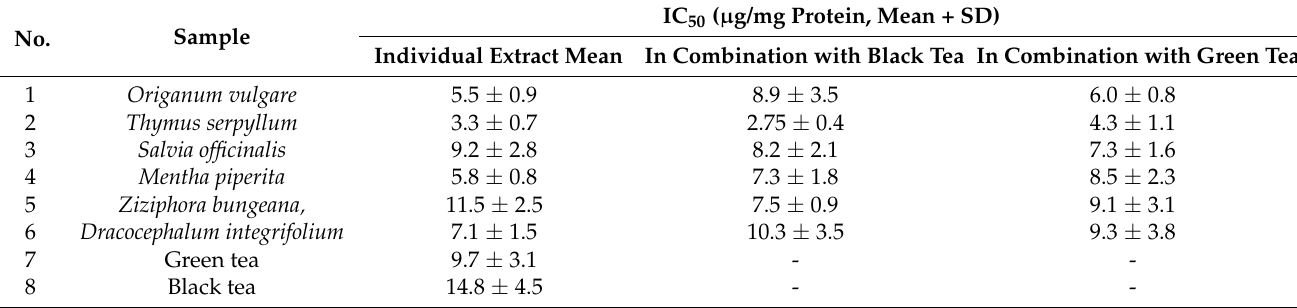
Table 4. The 50% inhibitory concentration IC 50 values for the effects of combination extracts of plants and tea (mean + SD).